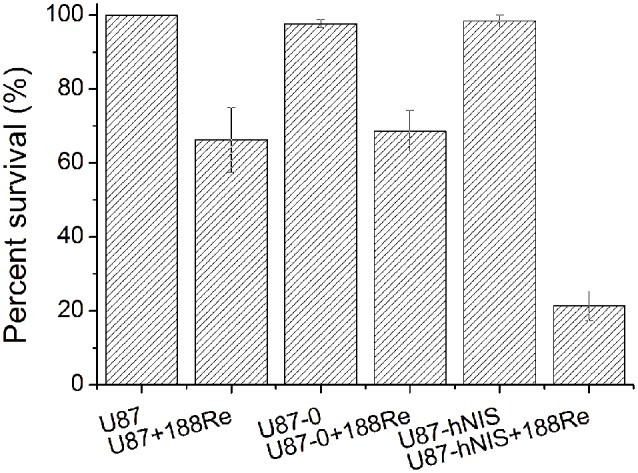
Survival rates of U87-hNIS cells treated with 740 kBq 188Re/mL 188Re.Groups 2, 3, 4, 5, and 6 all served as controls. Bars are means ± SD (n = 3).